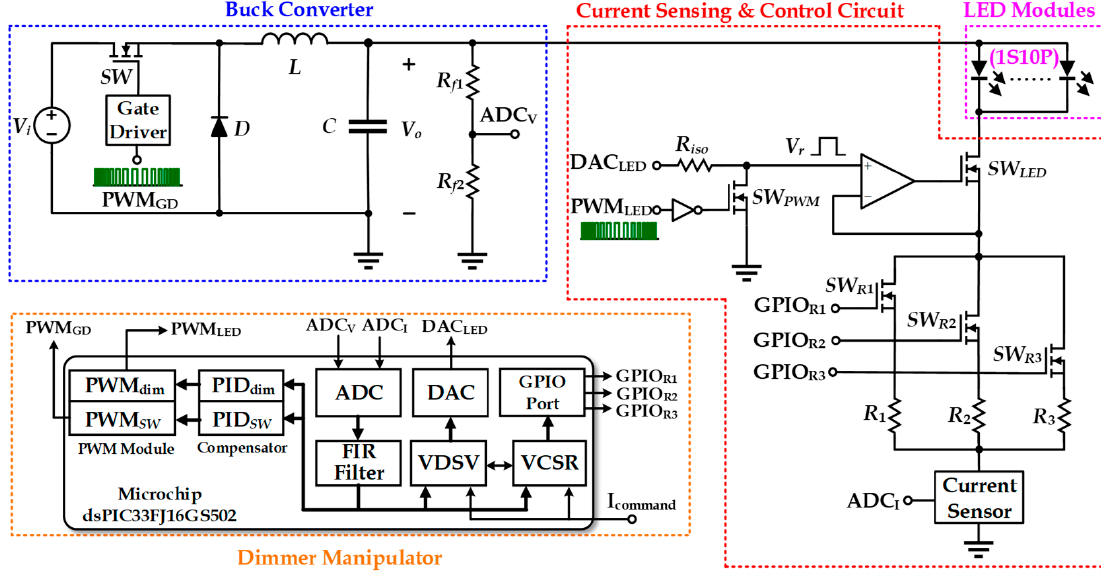
Figure 2. Configuration of the LED driver studied.